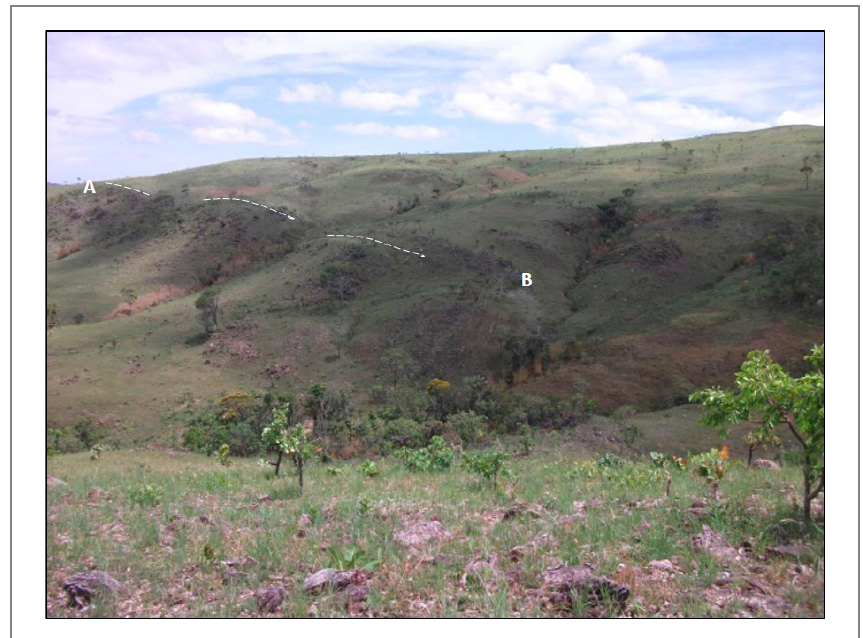
FIGURE 2 - View of the Serra da Borda hills to the northeast of the São Francisco mine with part of the break of slope ridge (A-B) sustained by siliceous breccias, as indicated by traced